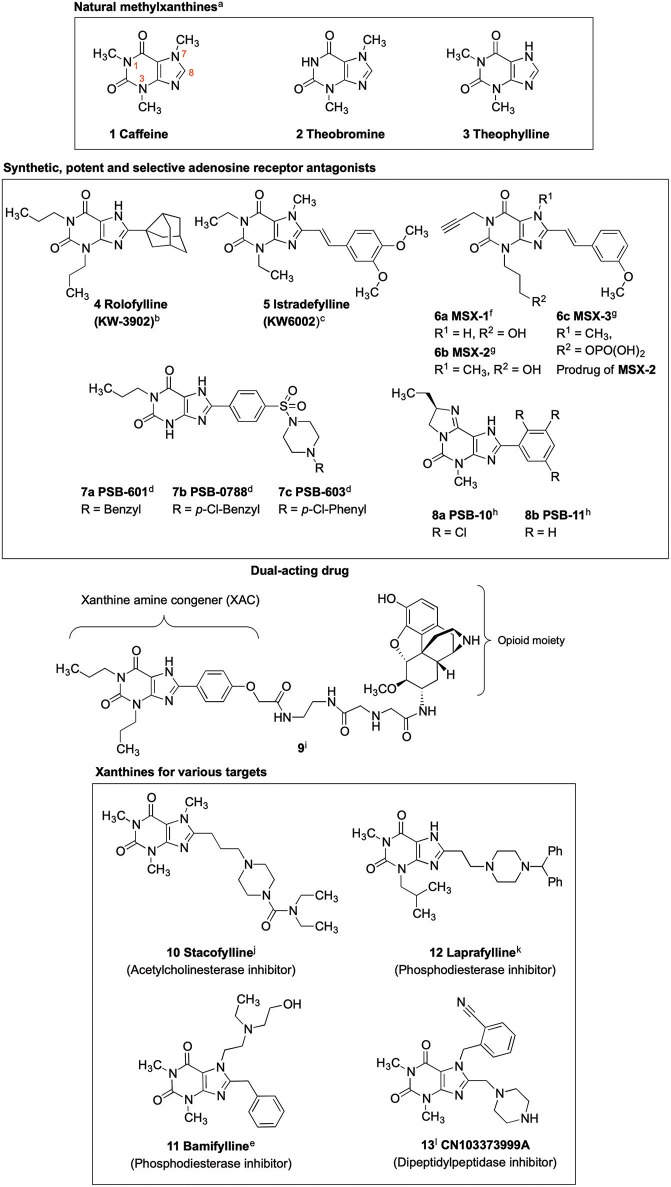
Xanthine-based drugs. a(Franco et al., 2013); b(Slawsky and Givertz, 2009); c(Park and Stacy, 2012); d(Borrmann et al., 2009); e(Alciato et al., 1990); f(Sauer et al., 2000); g(Hockemeyer et al., 2004); h(Ozola et al., 2003); i(Jacobson, 2009); j(Gallagher, 2004); k(Baraldi et al., 2007); l(Costante et al., 2015).